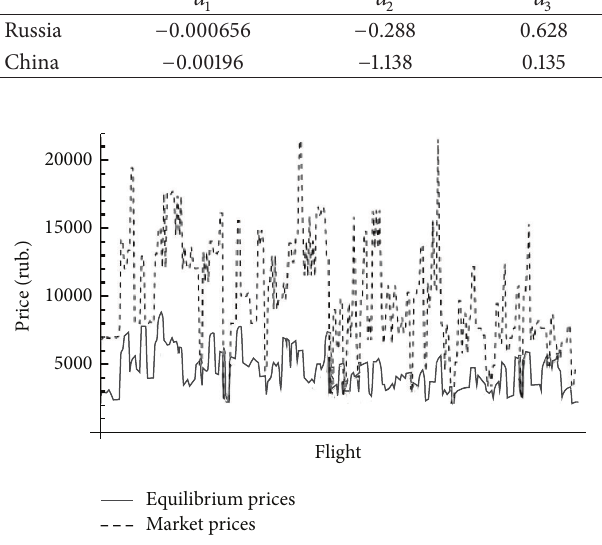
Figure 3: Equilibrium prices (Russian market).